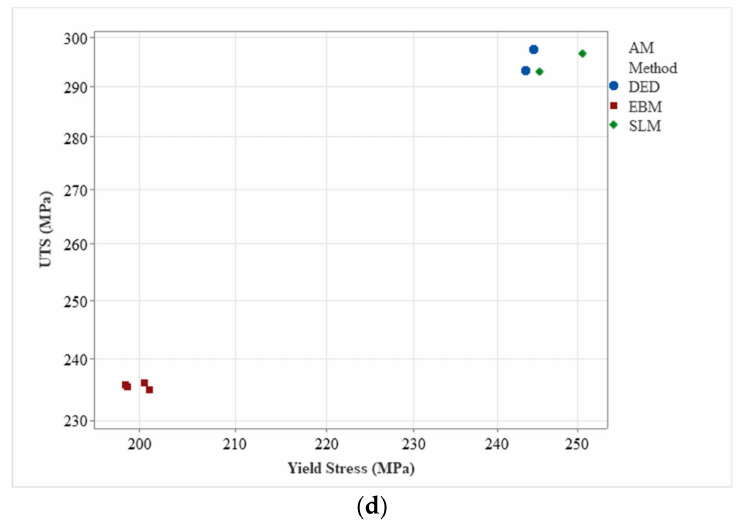
Figure 9. ( a ) Dependence of tensile elongation on the cooling rate of Ti6Al4V for different grains. ( b ) Fatigue life of HIPed and non-HIPed SLM and EBM samples without notches (stress concentration factor (K t ) =1). ( c ) Stress–strain curve for the dog bone coupon manufactured using SLM, DED, and EBM. ( d ) Comparison of yield stress and UTS for SLM manufactured using SLM, DED, and